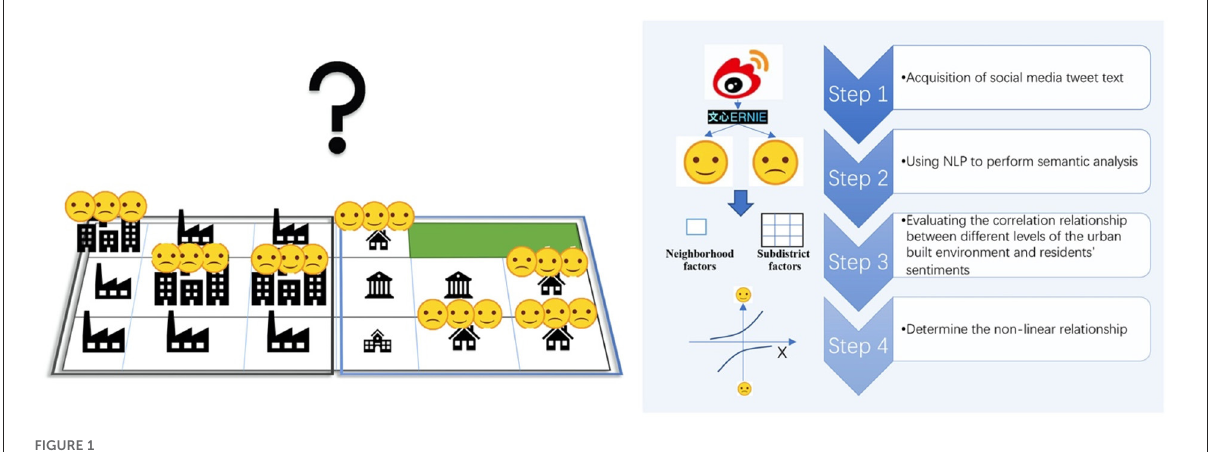
FIGURE1 Technical